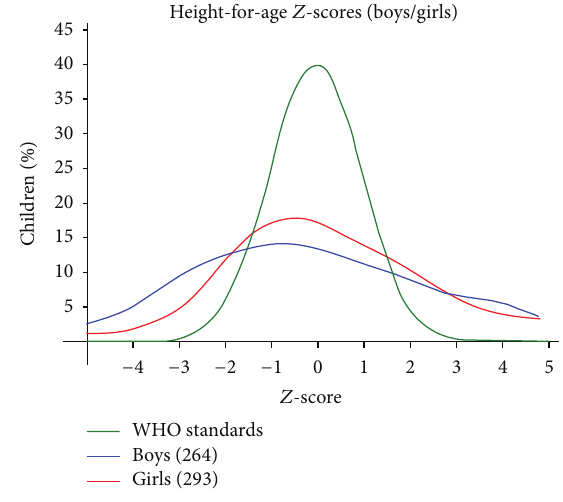
Figure 2: Distribution of chronic undernutrition/stunting by sex among children 6–23 months of age residing in Kemba Woreda, Southern Ethiopia,